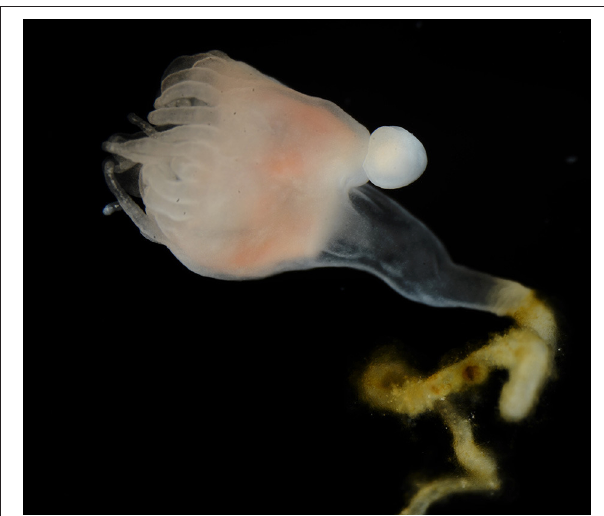
FIGURE 3 | A Cassiopea xamachana poylp with a planuloid bud developing asexually from the aboral region of the